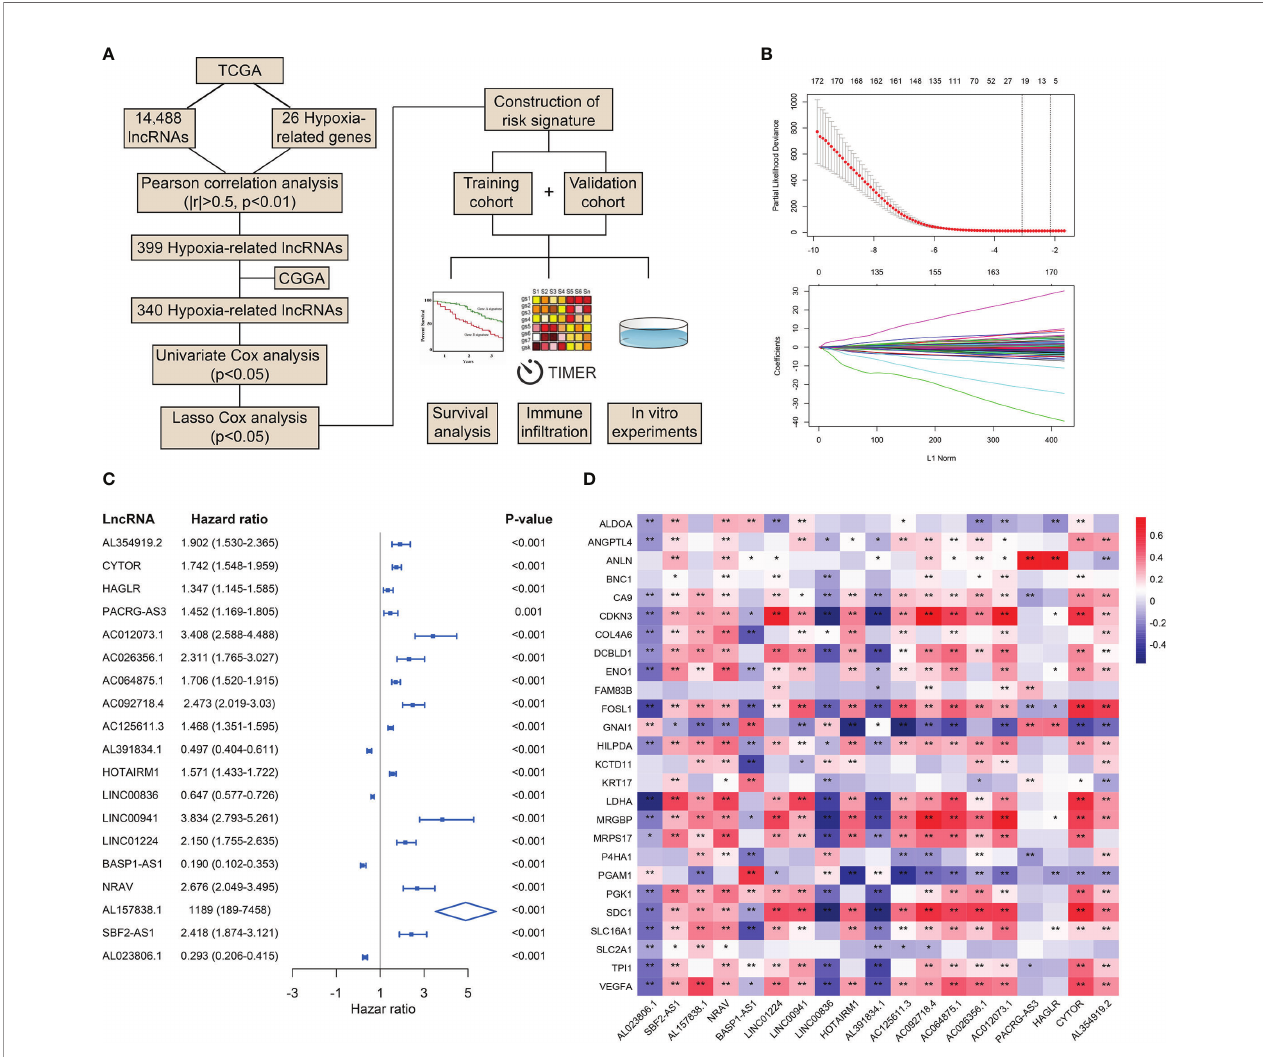
FIGURE 1 | Identi fi cation of HRLs in the TCGA and CGGA datasets. (A) Flow chart of the whole study. (B) Lasso analysis of prognostic HRLs with minimum lambda value. (C) Univariate Cox analysis of 19 selected HRLs. (D) Heatmap of the correlation between hypoxia-related genes and HRLs. *p < 0.05, **p <